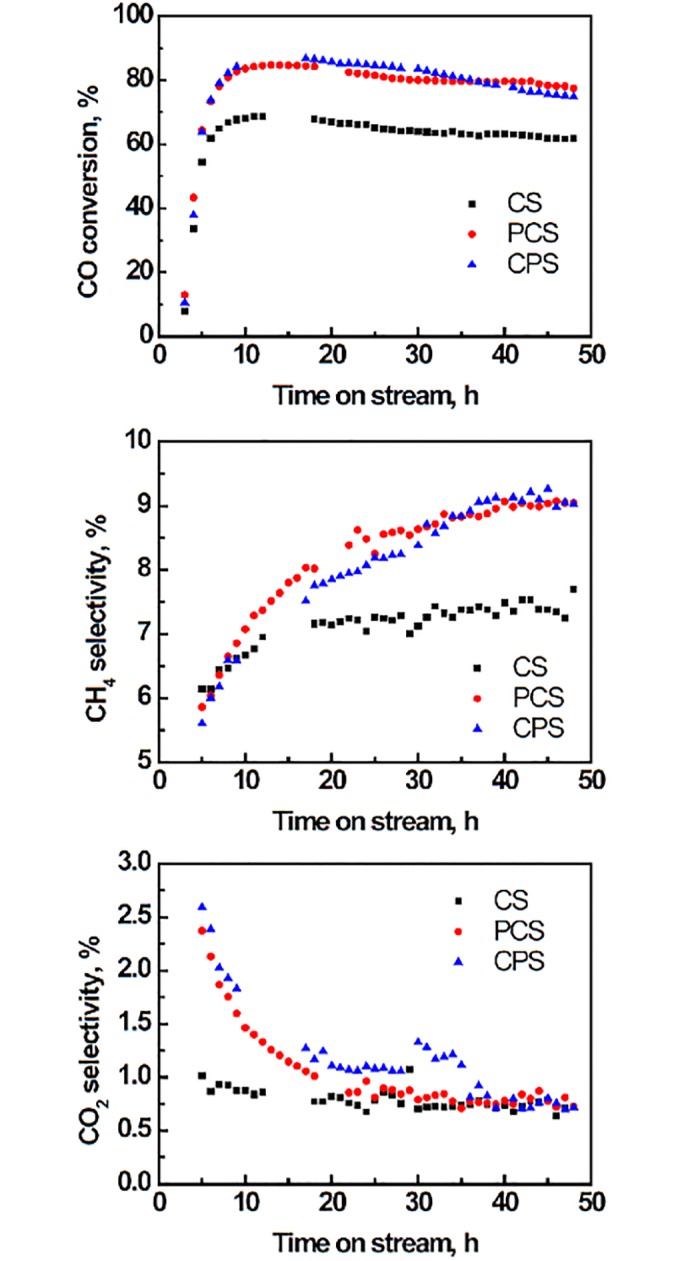
Activity and selectivity of modified Co/SiO2 catalysts in FT reaction.220°C, 2.0 MPa, 1.8 L/(h·g-cat), H2/CO/N2 = 6/3/1.